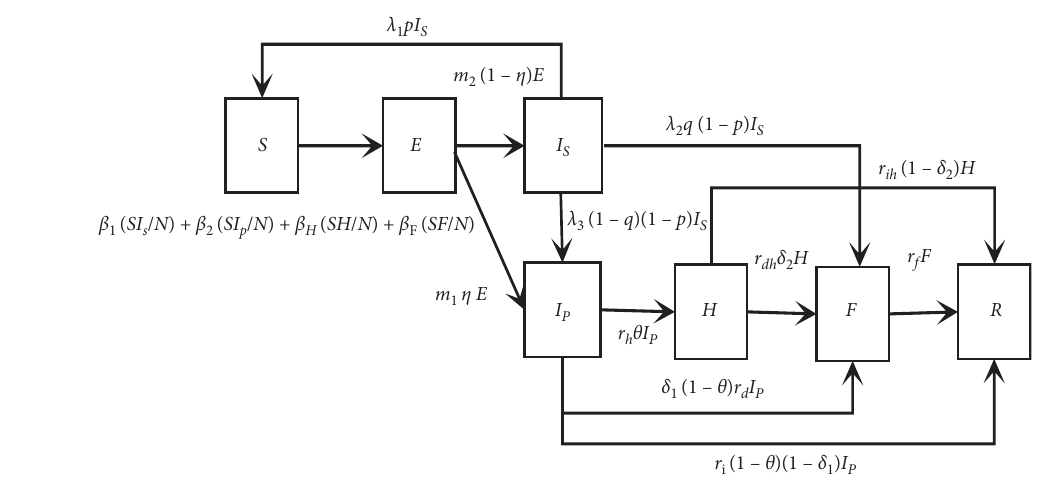
Figure 1: Ebola’s transmission mechanism in Sierra Leone. Table 1: Description of parameters in model (1).